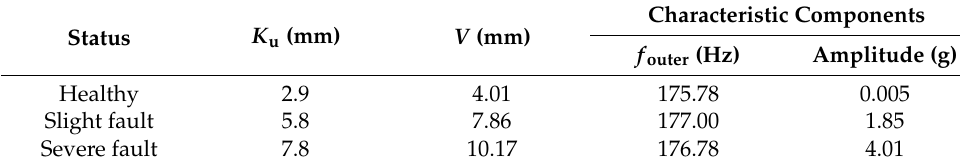
Table 5. Bearing outer race fault diagnosis results of Y100L-2 motor with a half